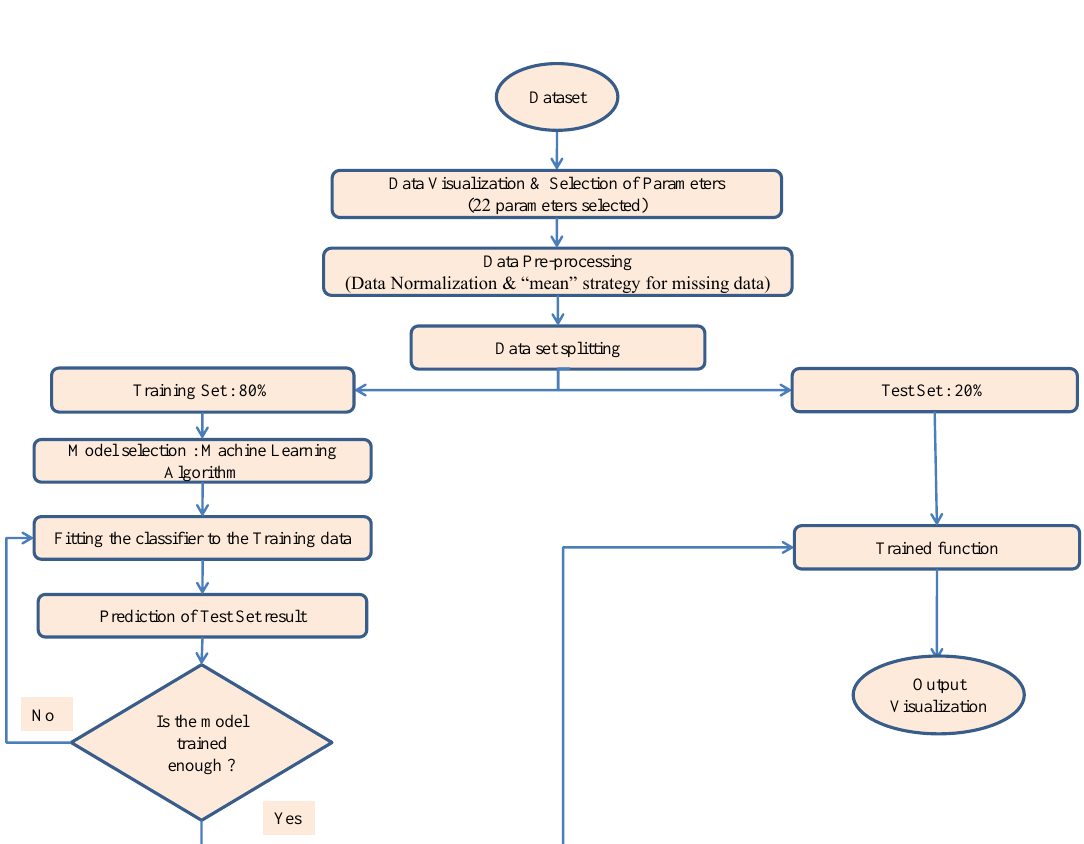
Figure 1. Flow chart for ML methodology